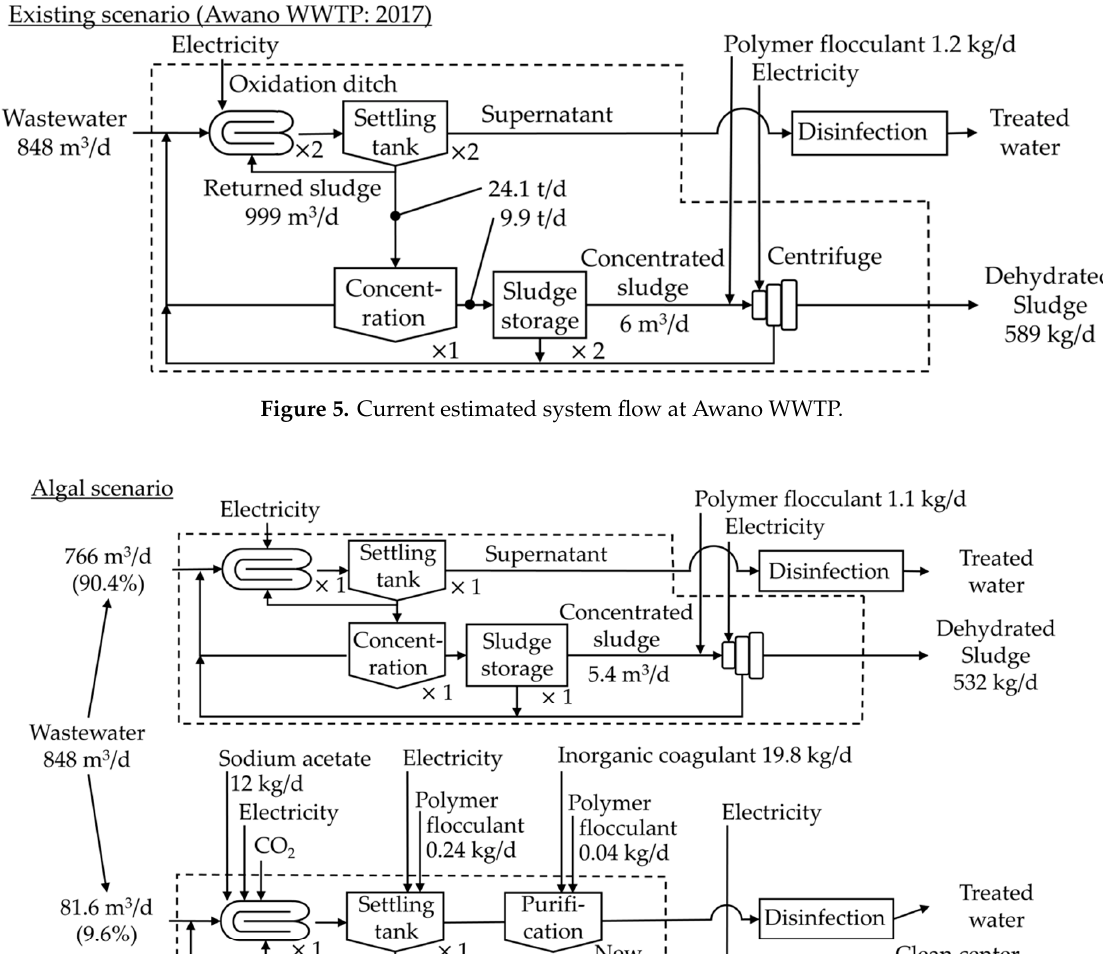
Figure 6. Introduction of the microalgae oil production system at Awano WWTP.